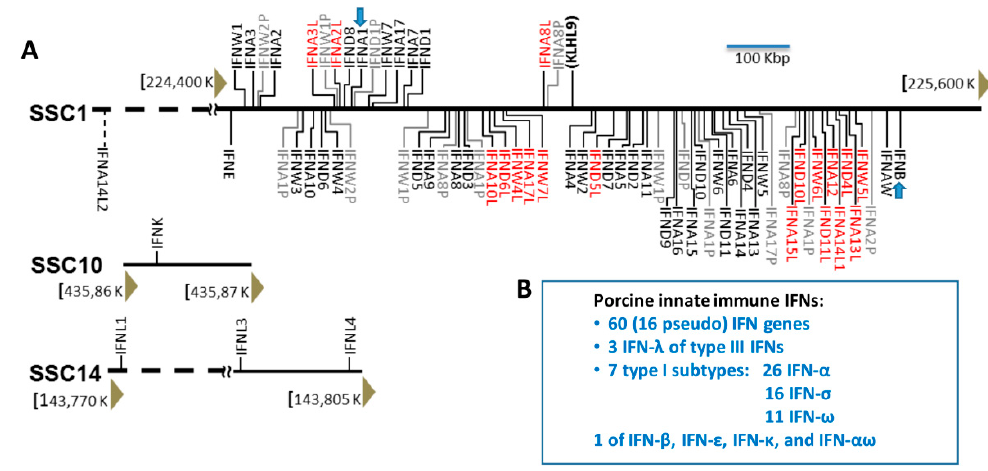
Figure 1. Molecular composition of porcine innate immune interferon (IFN) genes in the current porcine genome assembly. ( A ) There are 60 functional genes of porcine innate immune IFNs, which include three type III IFN- λ s located on S. scrofa chromosome (SSC) 14, and 56 type I IFN genes cluster on SSC1 except IFN- κ on SSC10 due to a chromosomal recombination event happened in swine evolution. The type I IFN gene cluster include 18 duplicates (labeled in red), each identical to one of the previously identified IFN genes; therefore, there are 39 parsimoniously non-redundant porcine type I IFN genes plus 18 duplicates and 16 pseudogenes probably resulting from recent gene duplication / evolving events upon increasing antiviral or development pressure. The typical IFN- α (represented by IFN- α 1 or few other IFN- α isoforms) and IFN- β subtypes are indicated with blue arrows. ( B ) Most other unconventional subtypes of porcine IFNs including three IFN- λ s and five subtypes of type I IFNs have not been well examined for their antiviral potency in different viral disease models. Gene symbol legend: black, functional genes; grey, pseudogenes; red, duplications to the indicated ones (for examples, IFNA1L has 99–100% sequence identity to IFNA1; dashed line, unassembled piece. KLHL9, kelch-like protein 9-like gene in the middle of type I IFN gene locus. Adapted from Sang et al., 2014 [5].